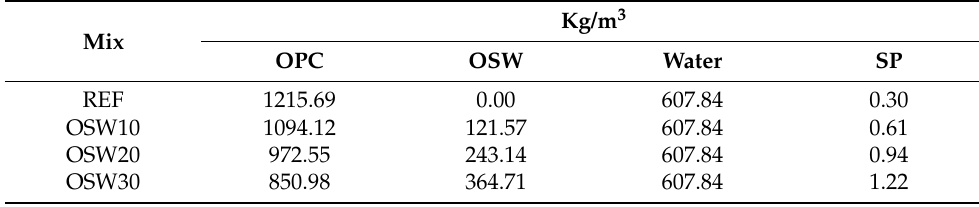
Table 1. Consumption of materials per m 3 of